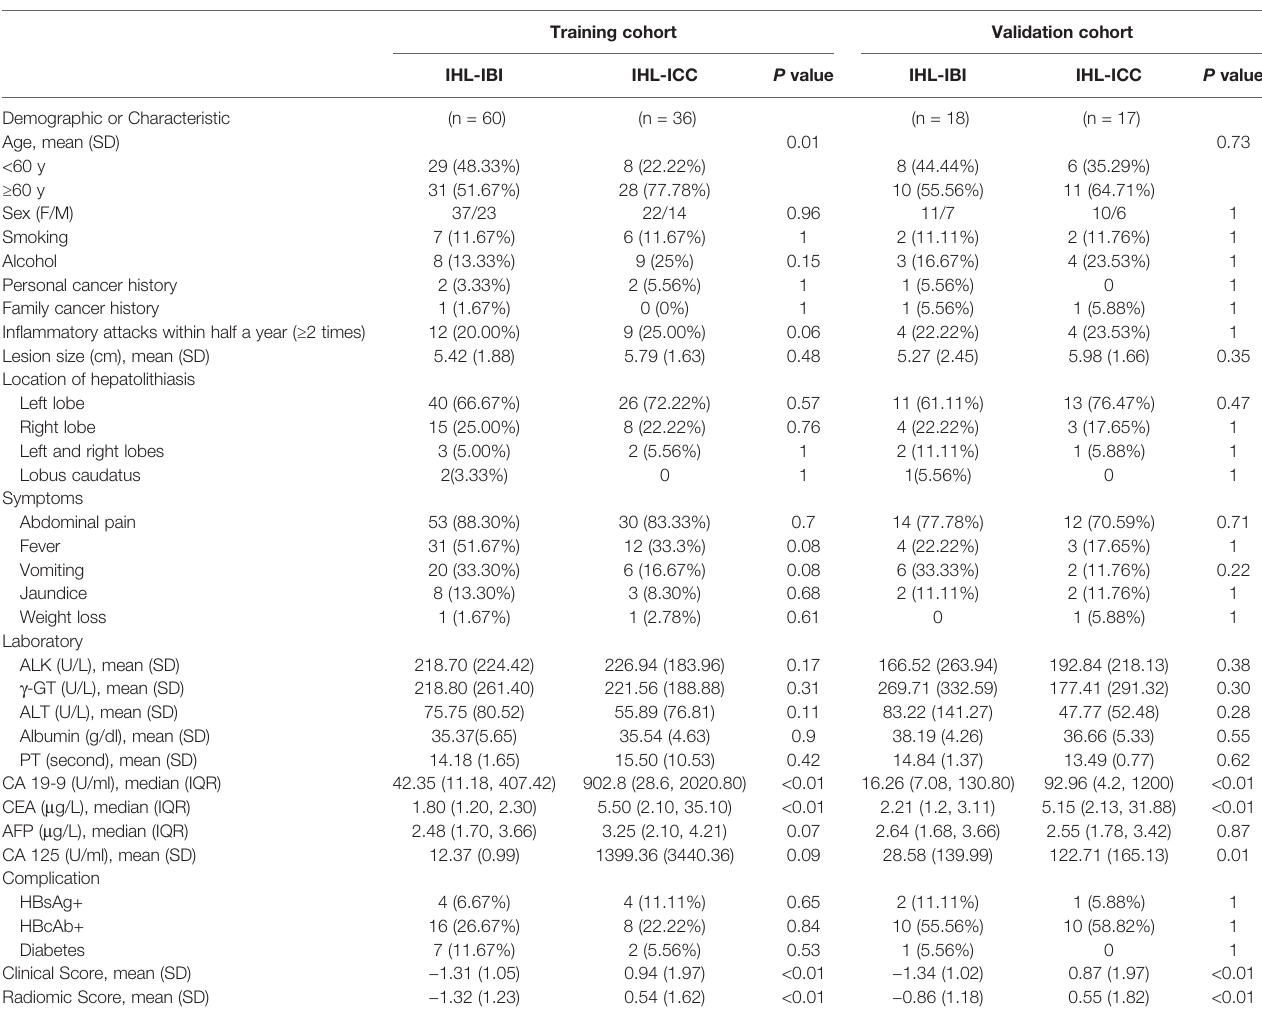
TABLE 1 | Demographic and clinical characteristics of the study